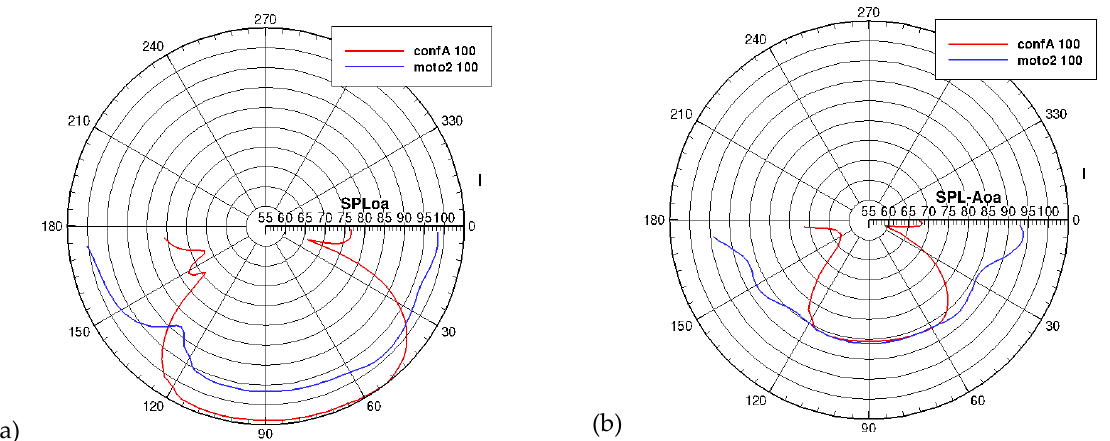
Figure 27. Comparison between Configuration A and Motorization 2; OASPL values on longitudinal XZ plane ( a ), A-weighted values on ( b ). Flight condition Climb 100% ETR.